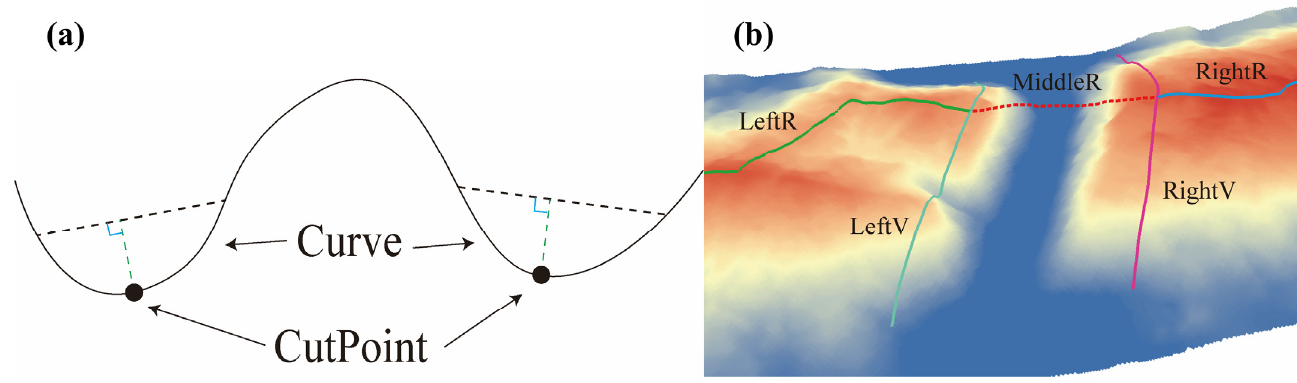
Figure 9. Optimizing the boundary lines of the transverse canyon. ( a ) The inflexion-point recognition bending method for calculating cut points and ( b ) the 3D boundary lines (LeftV and RightV) of C4 after the cut-off.